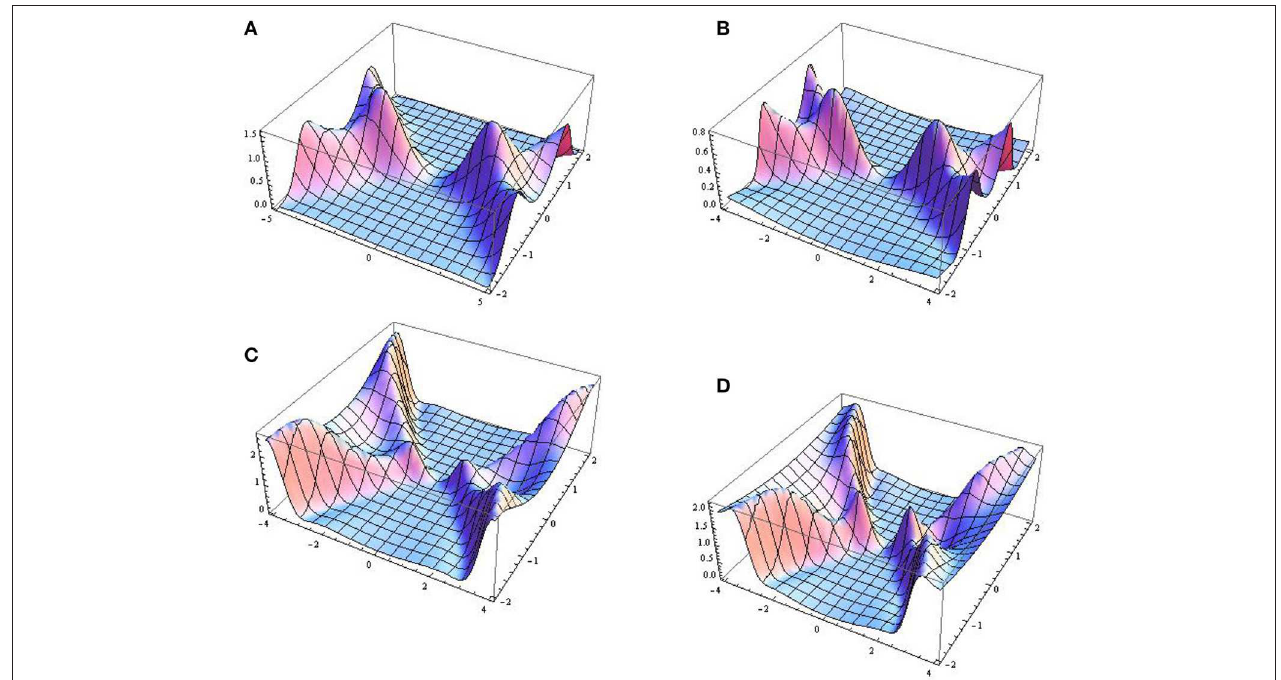
FIGURE 4 | 3D graphical representations of second-order rogue waves. These are constructed with (A) b b 0.9, δ 0 ( t ) 0.001 t and α = = α 35tan 2 (0.05 t =